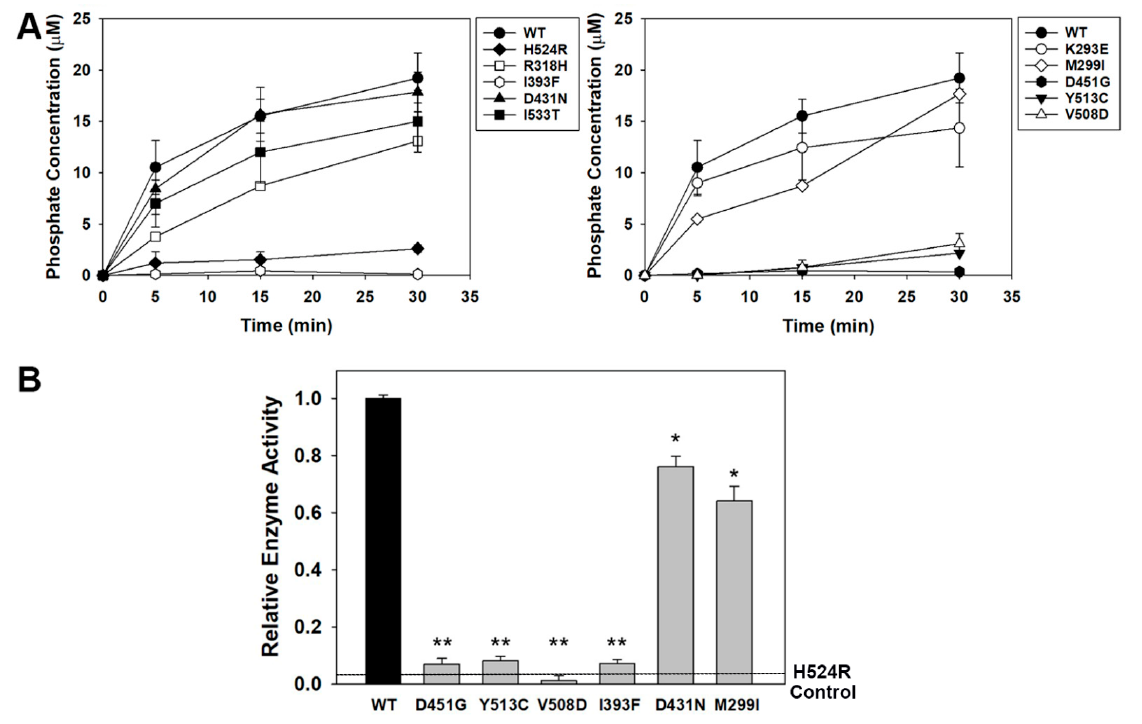
Figure 3. Phosphatase activity displayed by OCRL1 WT/VAR . Phosphatase activity of the selected variants was measured utilizing the malachite green assay, as detailed in Materials and Methods, and using Full length OCRL1 WT/VAR immunoprecipitated from human cells ( A ) or the variant’s recombinant, isolated phosphatase domain produced in and purified from bacteria ( B ). ( A ) The biologically relevant, full length indicated OCRL1 variants were tested for their ability to catalyze the release of inorganic phosphate from PI(4,5)P 2 as a function of time. The phosphatase dead variant pH524R was used as negative control. ( B ). Experiments using an isolated domain were performed to con fi rm the detrimental direct e ff ect of the missense mutations on the enzymatic activity of the variant’s catalytic domain. Statistical signi fi cance of the di ff erences between normalized catalytic activity of OCRL1 VAR and WT was assessed using the t-test with p < 0.05, applying Bonferroni’s correction for six comparisons: α B ≤ 0.008 (*) and α B ≤ 0.001 (**) for individual comparison.